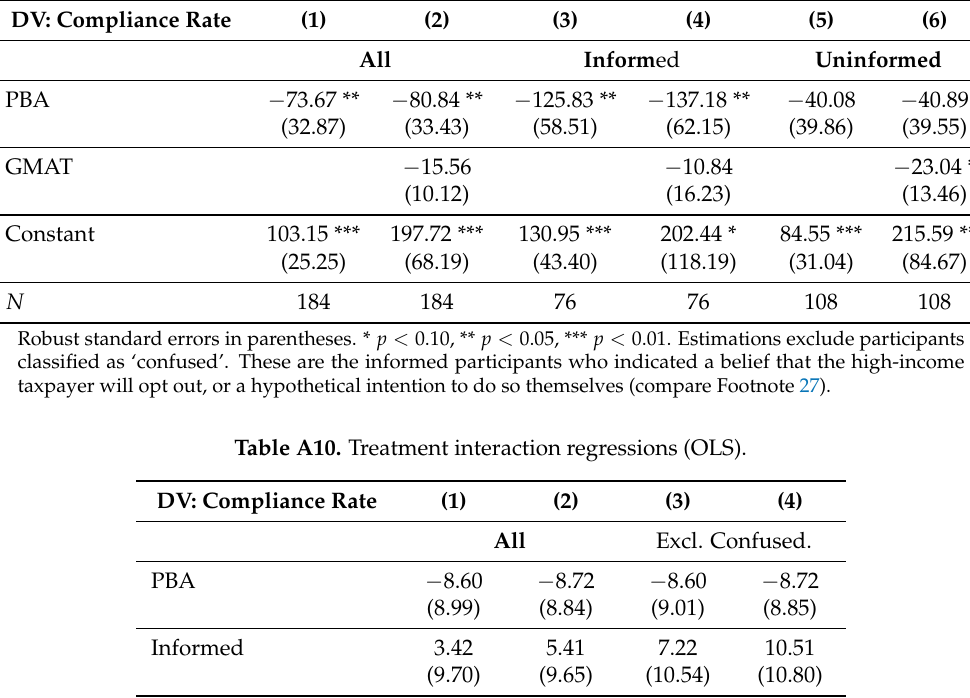
Table A9. Allocation treatment regressions (Tobit)—excluding ‘confused’.